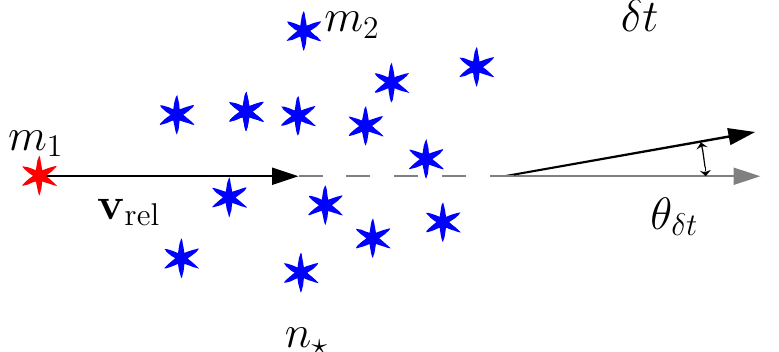
Fig. 14 The test stars suffers a change in direction by θ δ t due to the accumulation of encounters with field